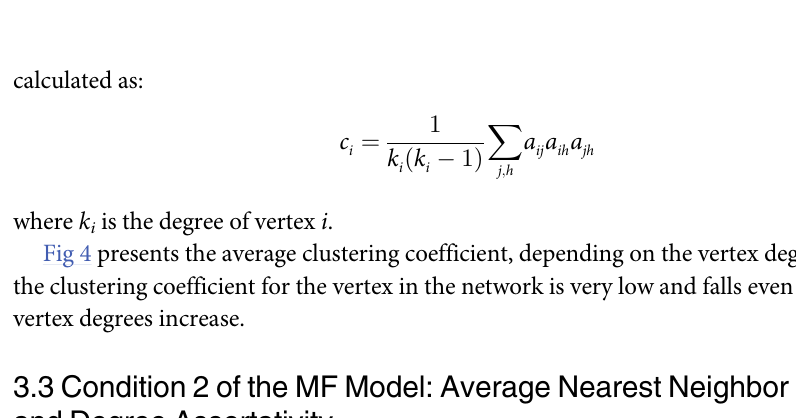
Fig 4. Average clustering coefficients ( c i ) versus vertex degree ( k i ), for each vertex and calculated for the time series of